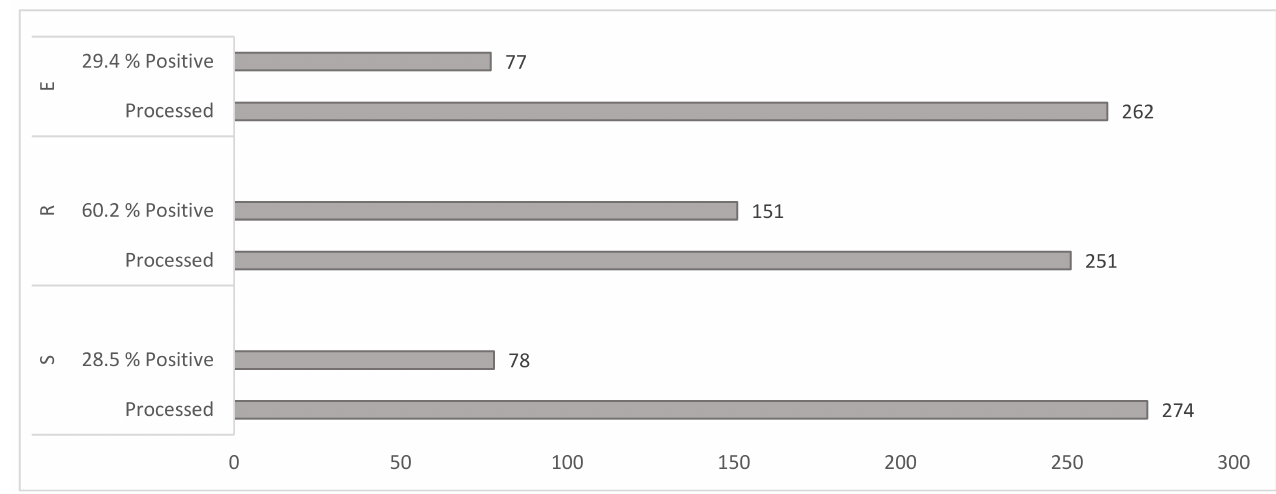
Figure 2. Yield of mycobacteria. Figure interpretation. S = water sediments (including sewage sludge from wastewater treatment plants), R = raw plant material and peat, E = animals’ faeces and matrices of animal